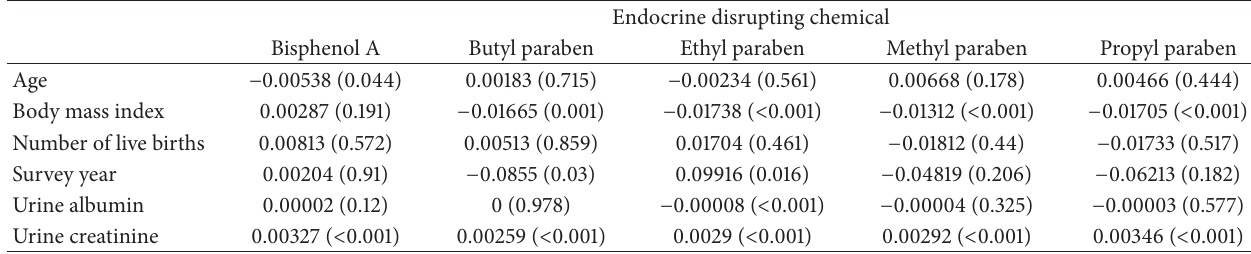
Table 4: Regression slopes with 𝑝 values for selected endocrine disrupting chemicals (EDC) for females aged 20–44 years. Data from the National Health and Nutrition Examination Survey 2005–2010.